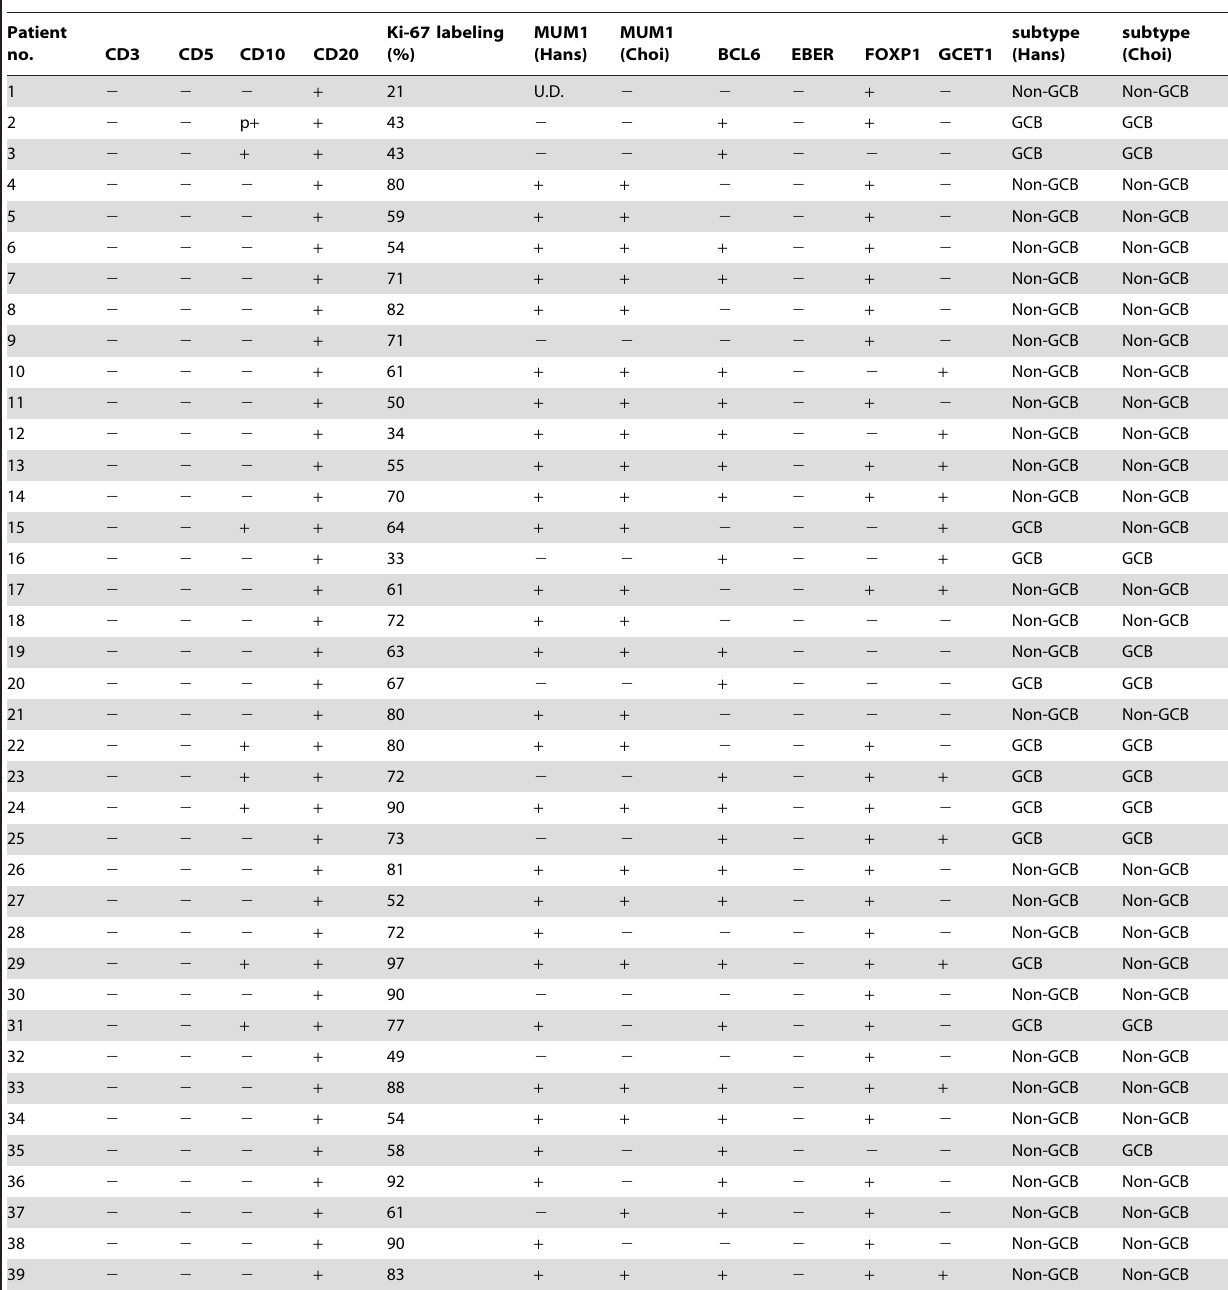
Table 4. Immunohistochemical findings of localized nasal/paranasal DLBCLs.